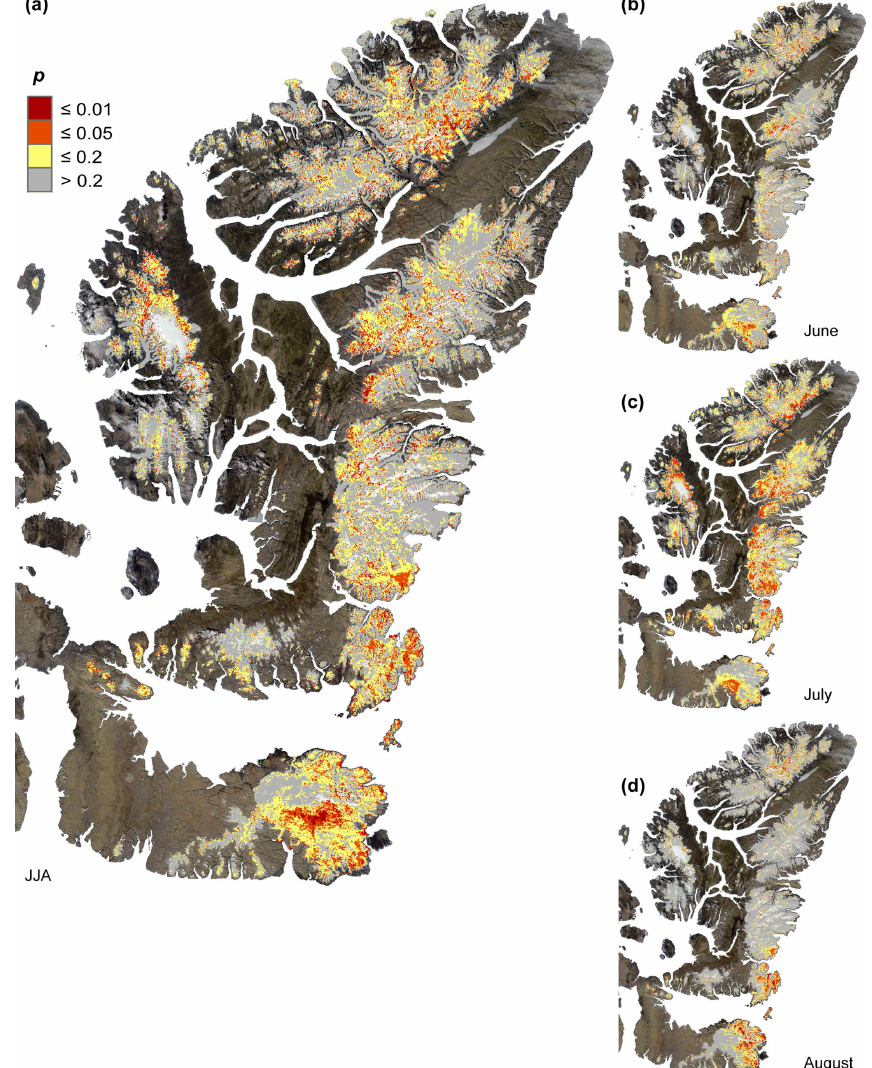
Figure 6. p value of the linear regression (Fig. 5) of (a) mean summer (JJA), (b) June, (c) July, and (d) August clear-sky shortwave broadband black-sky albedo for the period 2001–2016 over the QEI ice caps. Background image: MODIS, 4 July 2011. Brown indicates non-glaciated land